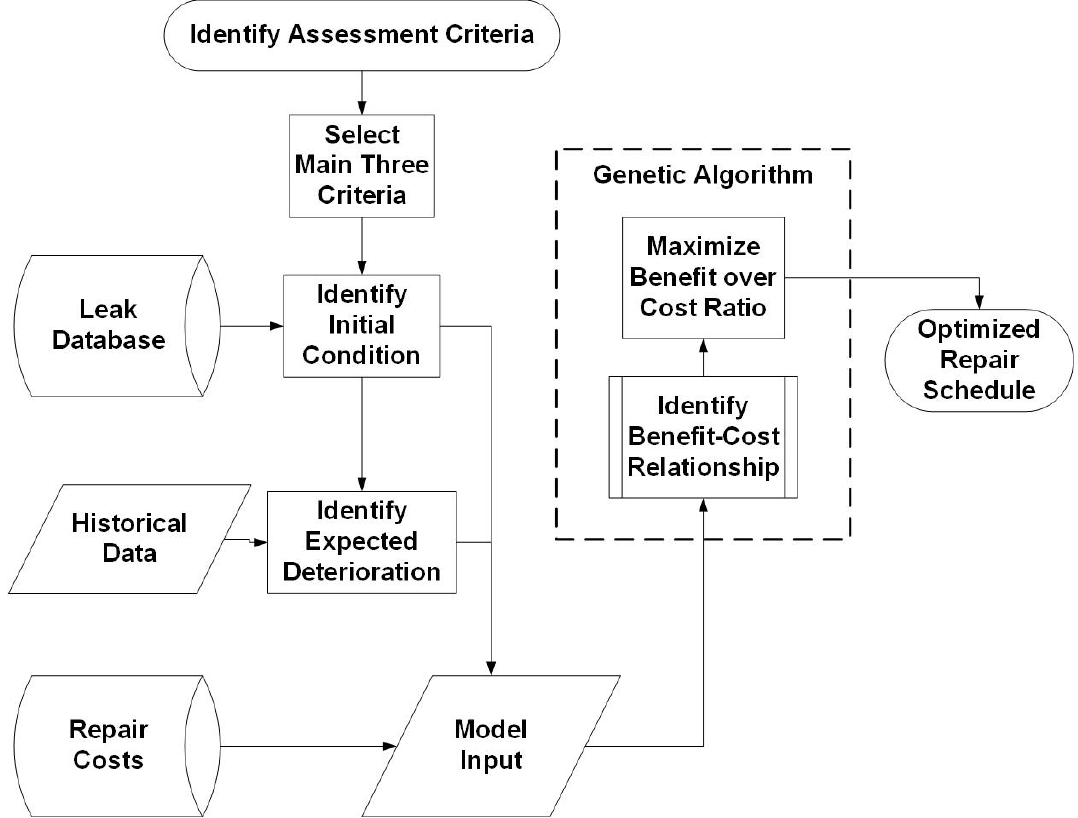
Figure 7. Genetic algorithm model methodology.